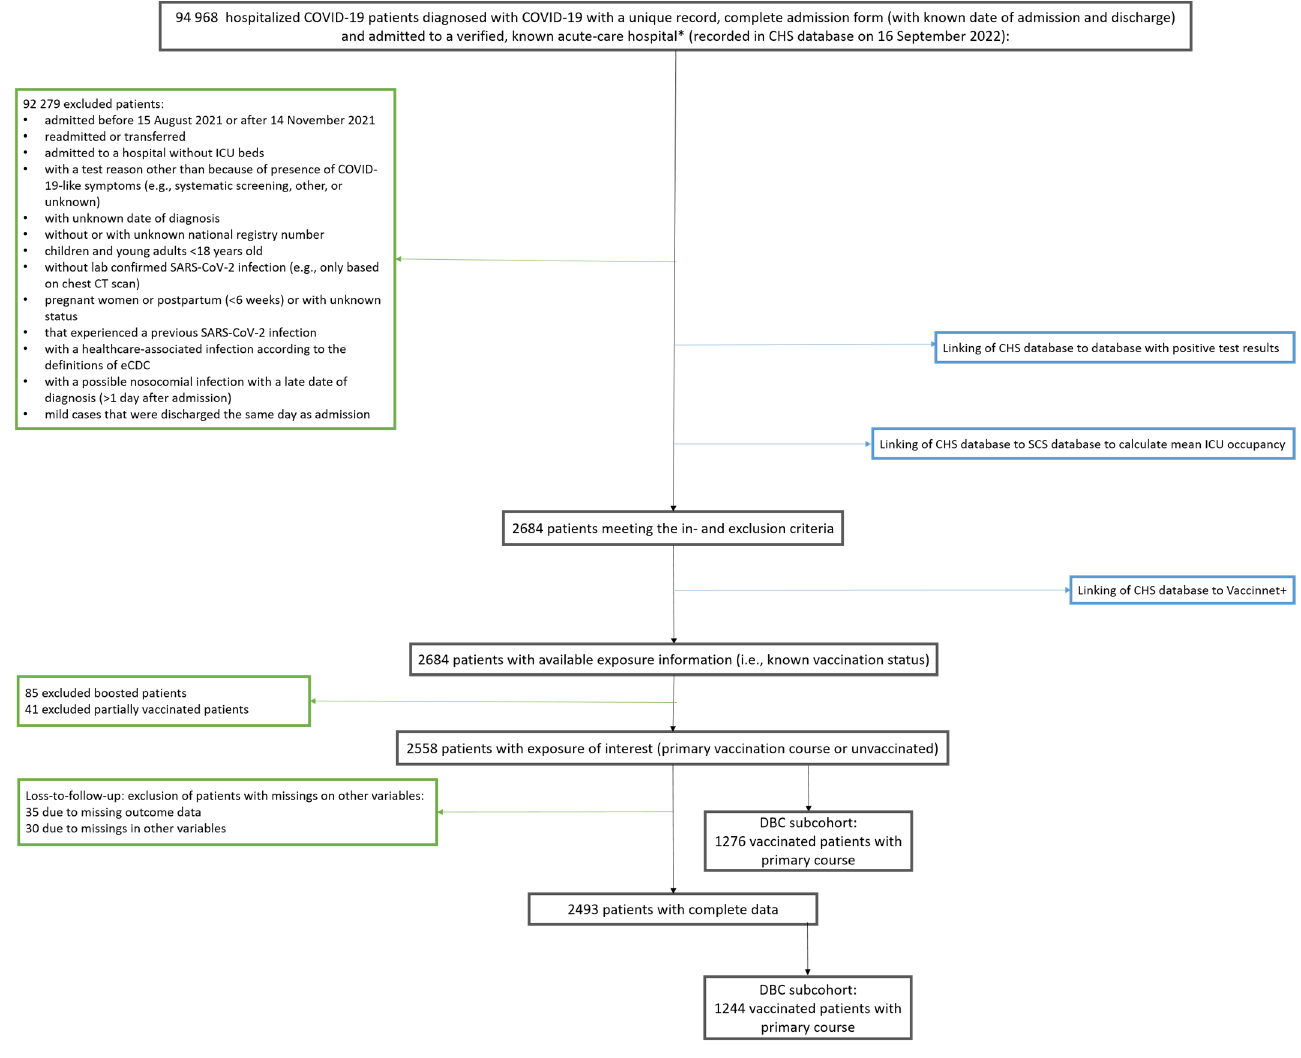
Figure 2. Flowchart for selection of study populations: total cohort and Delta breakthrough cases subcohort. Black boxes show the number of patients throughout the selection process; green boxes show number of excluded patients with reasons for exclusion; blue boxes show linking with databases to obtain information at the indicated exclusion step during the selection process. DBC; Delta breakthrough cases, CHS; clinical hospital surveillance, SCS; surge capacity surveillance, ICU; intensive care unit * no psychiatric or military hospital. Table 1. Description study population (complete cases).